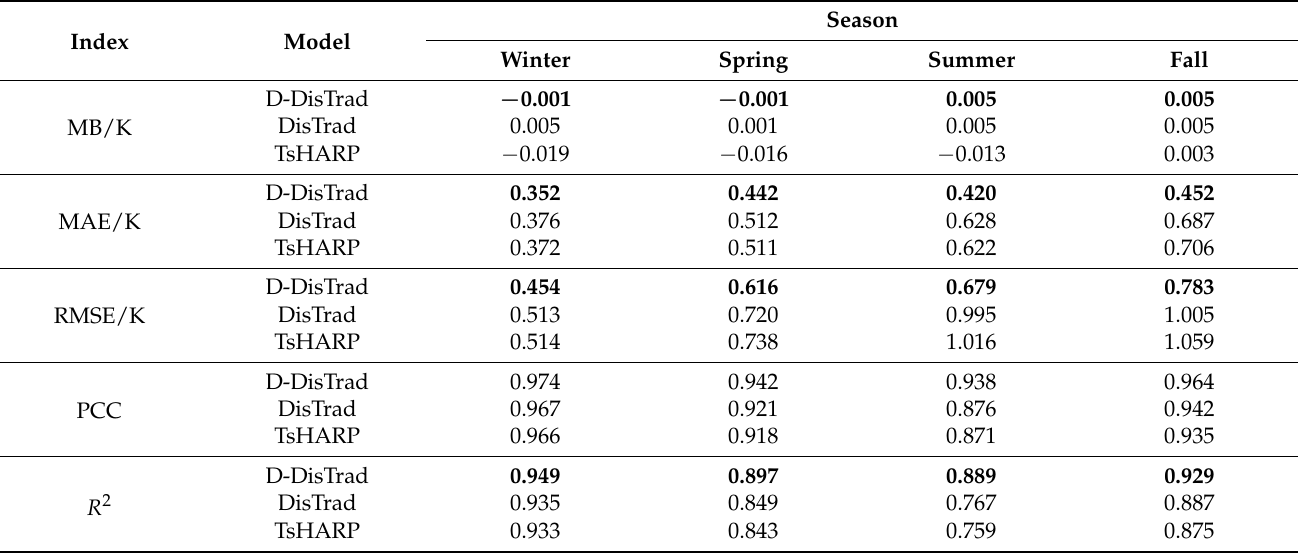
Table 7. The statistics of the three downscaling results aggregated to 900 m in comparison with the SLSTR LST data for the 4 seasons in site